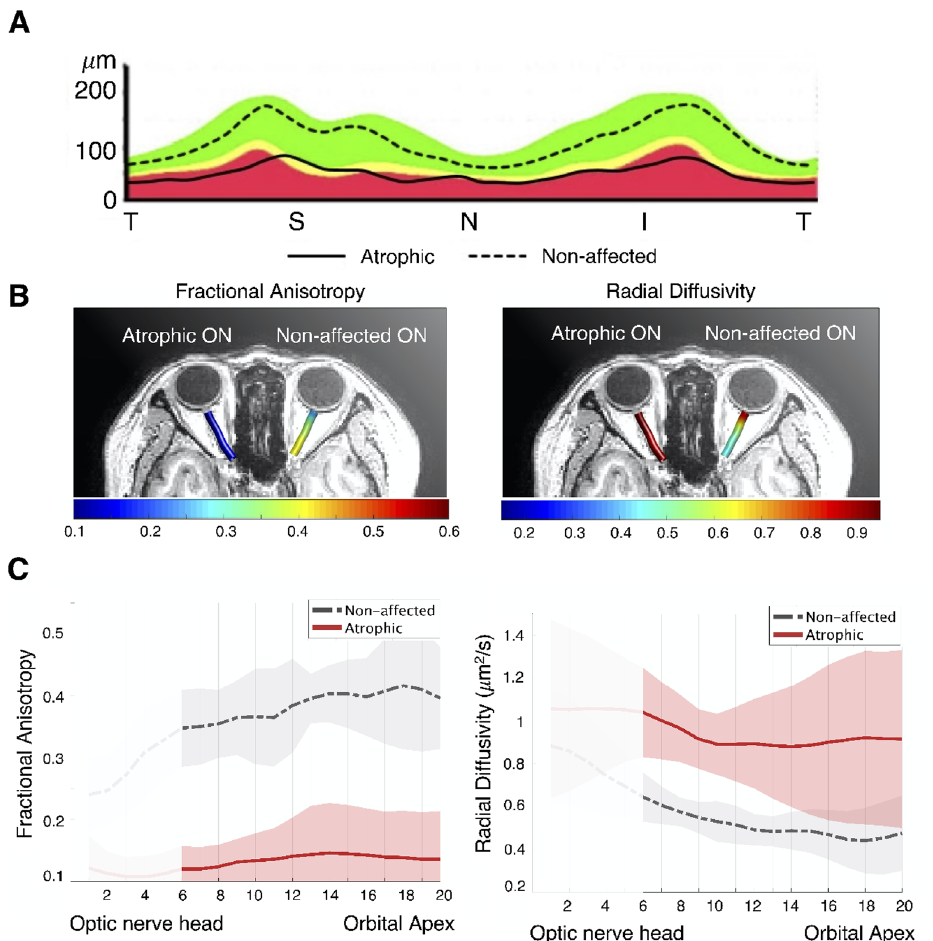
Figure 2. Visualization of the average peripapillary retinal nerve fiber layer (RNFL) thickness, diffusion measures, and tract profiles of six patients with optic nerve atrophy. ( A ) A plot indicating the average temporal- superior-nasal-inferior-temporal RNFL thickness of optic nerve head, measured at a circle with a diameter of 3.4 mm centered on the disc by optical coherence tomography. The RNFL thickness of the atrophic eyes (solid line) was significantly reduced compared to that of contralateral non-affected eyes (dashed line). ( B ) Optic nerve pathway mapping by the average fractional anisotropy and radial diffusivity ( µ m 2 /s) values for six atrophic optic nerves (ONs) and six non-affected ONs are presented in the left and right, respectively. ( C ) Average tract profiles across the ONs of six atrophic (red) eyes and six non-affected (gray) eyes plotted by mean lines with standard deviation and each node marked with dotted lines. Five nodes nearest the optic nerve head were excluded from the analysis and are shaded white in the